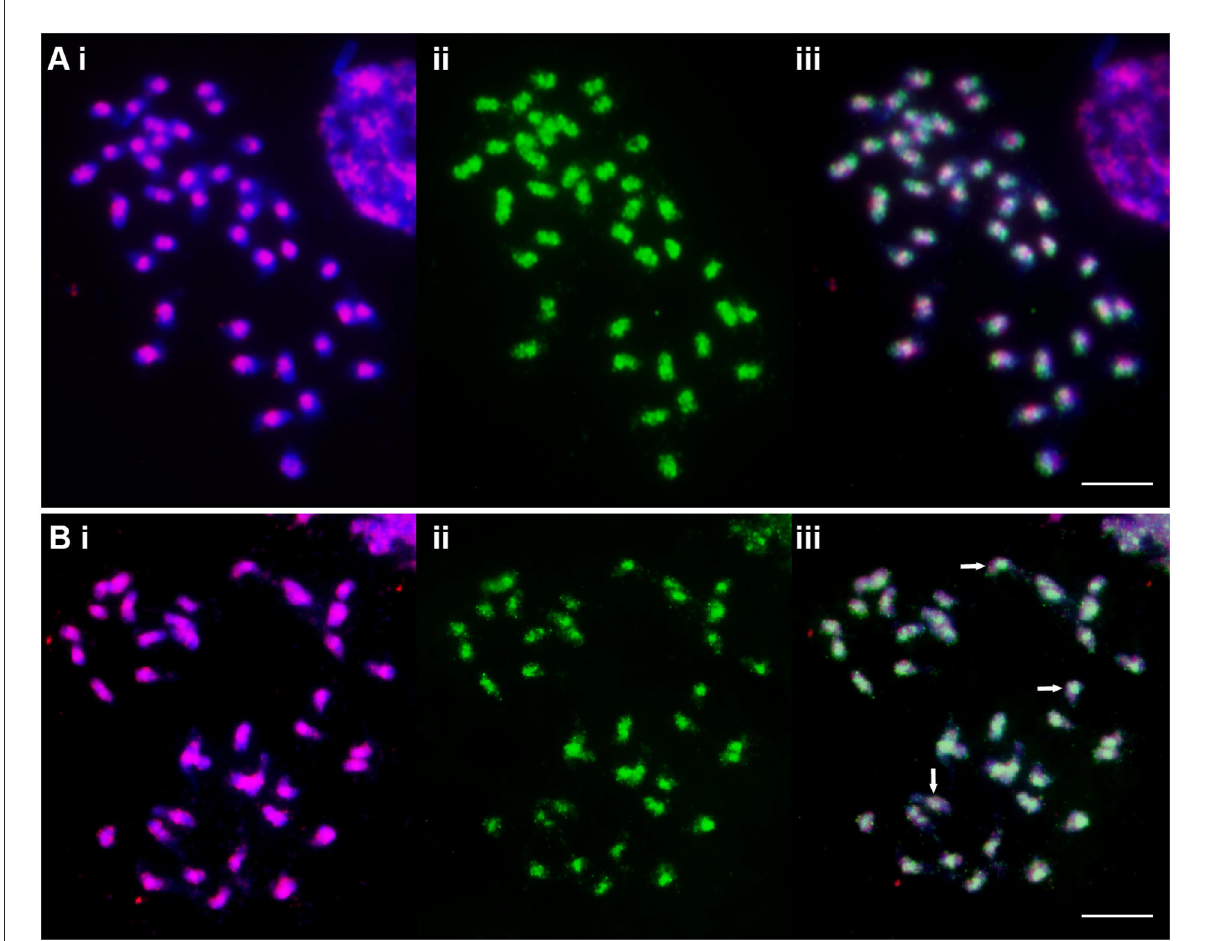
FIGURE2 Metaphase chromosomes of C. ciliaris (2 n = 4 x + 3 = 39) after FISH (red fluorescing, (i) and immunostaining with anti-5-methylcytosine (green fluorescing, (ii) and as an overlap image (iii) . (A) The “universal” Ty1- copia probe shows concentrated signal around the centromeres of all chromosomes, while 5-mC signal is not only seen overlapping them but also further along the chromosome arms. 5-mC strength is variable between the chromosomes with most showing a small gap at the centromeres. (B) The “universal” Ty3- gypsy probe shows a dispersed signal over the chromosome arms, but is absent from the most distal parts. 5-mC signal covers most Ty3-gypsy signals but is weak or absent in some cases (arrows). Scale bar = 10 µ m.